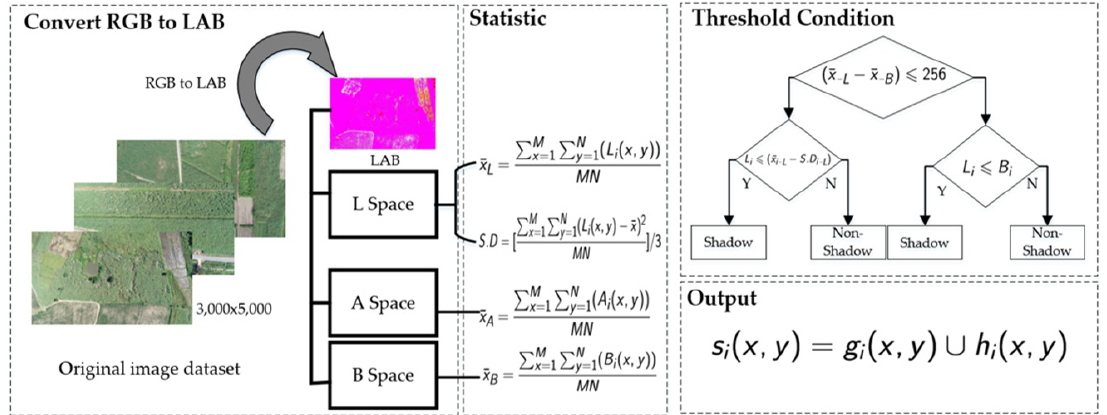
Figure 5. Shadow detection